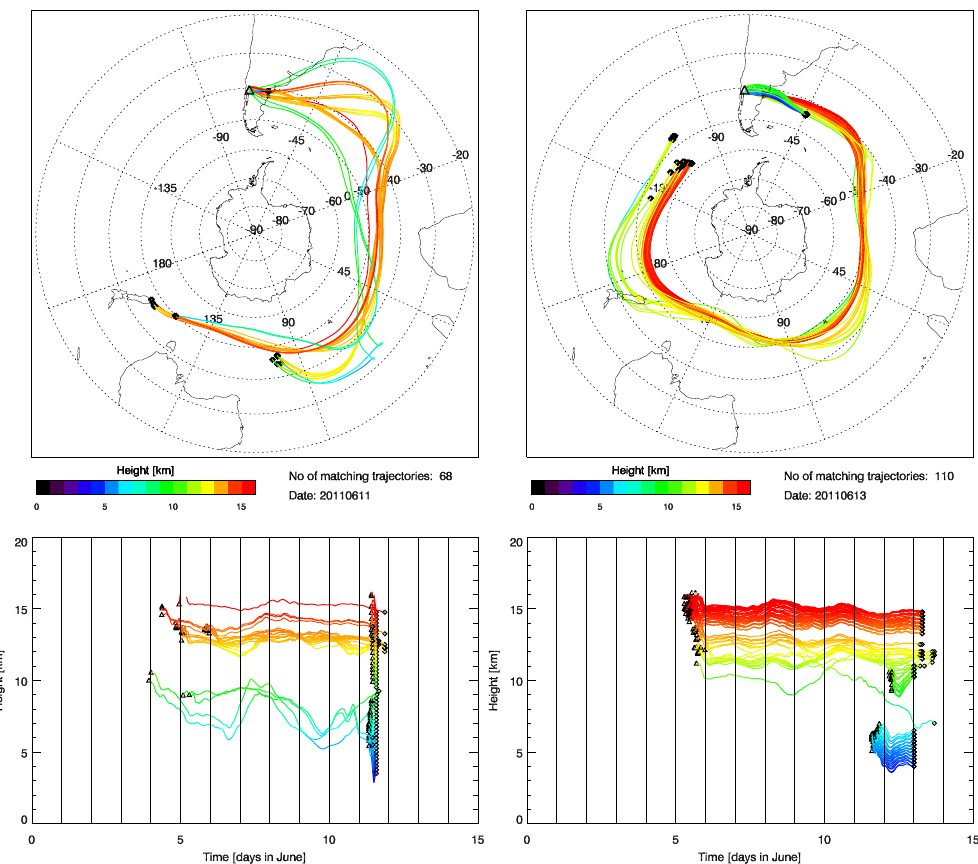
Fig. 5. Backward trajectories released for the IASI observations on 11 June (left) and 13 June (right) filtered for PCCE depicting the source– receptor relationship. In the bottom panel the matching backward trajectories are plotted as a function of height. The triangle symbolizes the volcano (source), the cross the observation (receptor where the backward trajectory was initialized). The observation time follows two groups, the ascending and descending orbit.